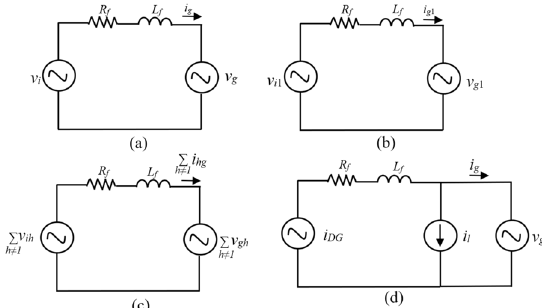
Fig. 4 Model of grid-connected DG system under distorted grid voltage condition and with nonlinear local